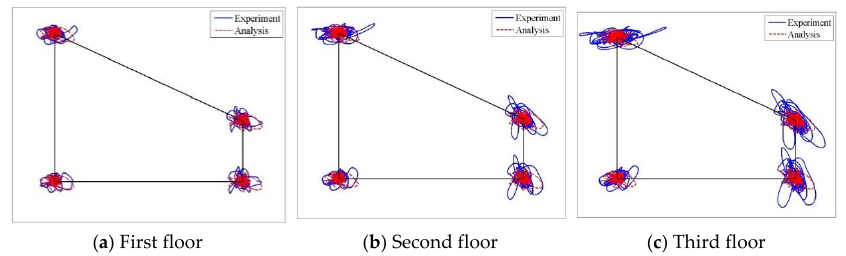
Figure 33. Displacement trace at sampling points during the Northridge main shock of Run 19.